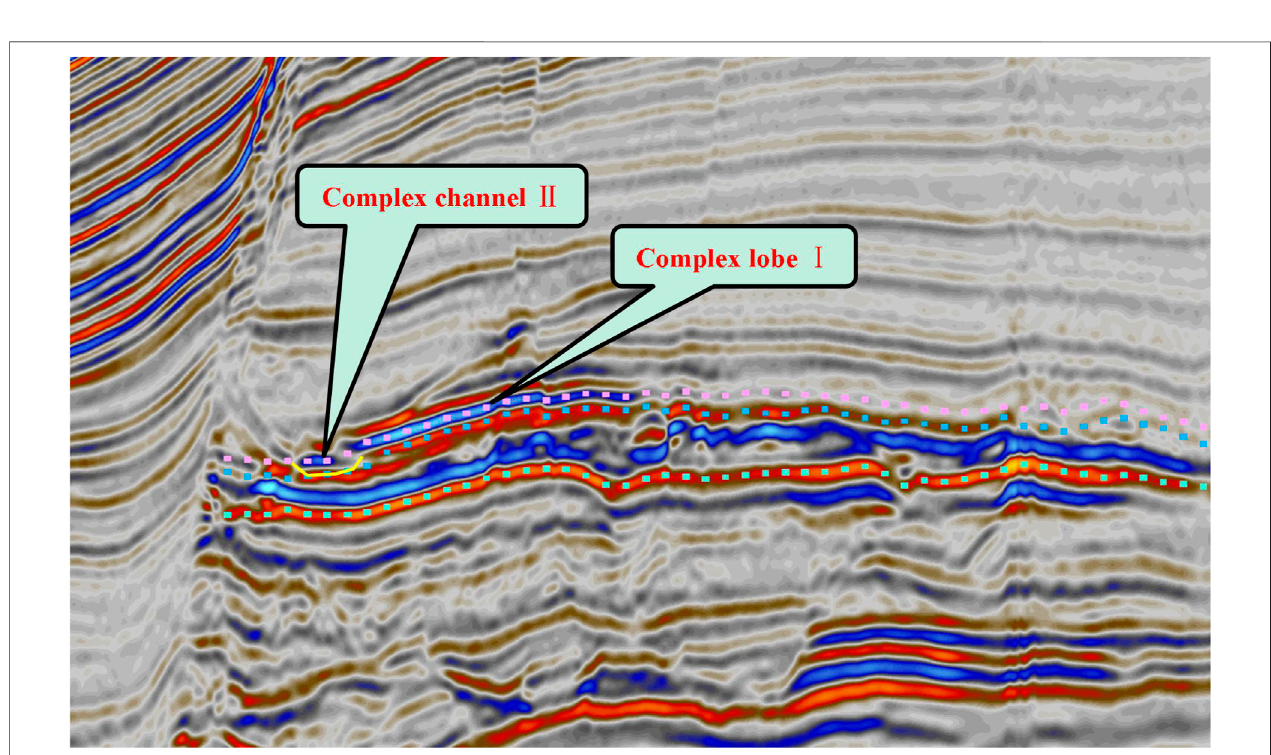
FIGURE 20 | Seismic section of the AB120 reservoir perpendicular to the source direction (remote source end).